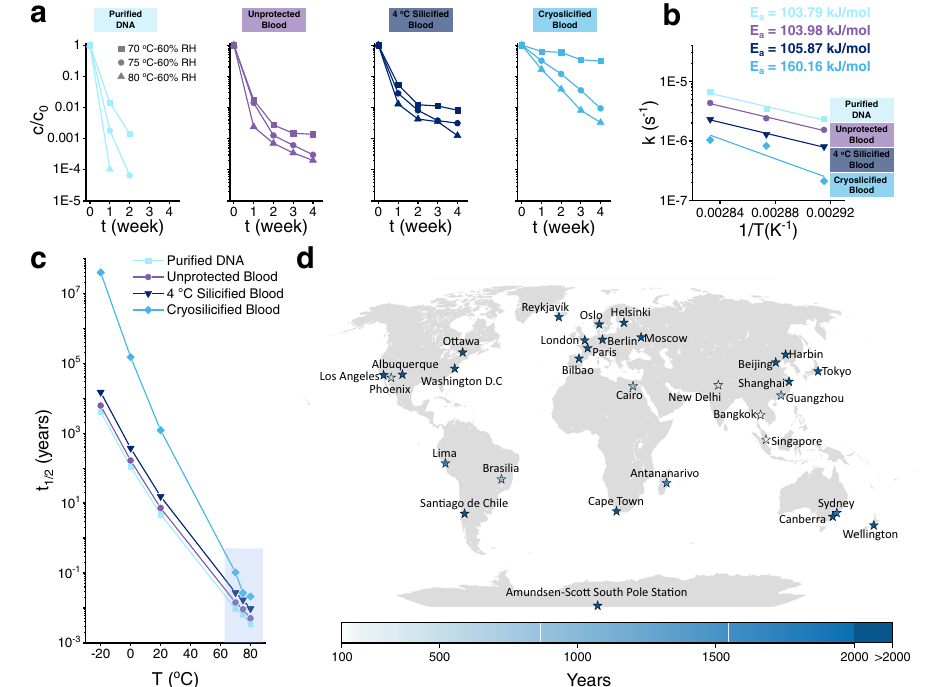
Fig. 5 | Degradation kinetics of DNA storage. a Concentration of target genomic fragments (G6) from puri fi ed DNA, unprotected blood, 4°C silici fi ed blood, and cryosilici fi ed blood samples after aging at 70, 75, 80°C and 60% RH. b Activation energies of targetgenomicfragments (G6) from puri fi edDNA,unprotectedblood,